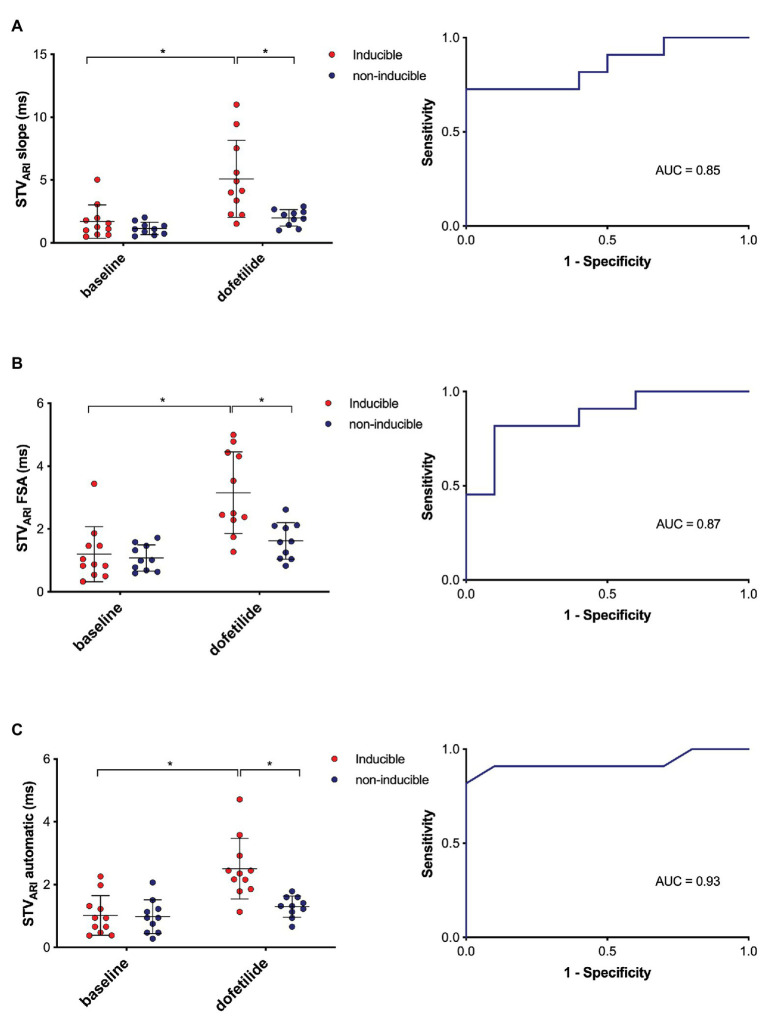
Predictive value of different methods of STVARI. STVARI at baseline and after dofetilide in inducible (red) and non-inducible dogs (blue) measured with the slope method (A), FSA method (B), and automatic method (C) with the corresponding receiver operating characteristics (ROC) curves. AUC, area under the curve. *p < 0.05.